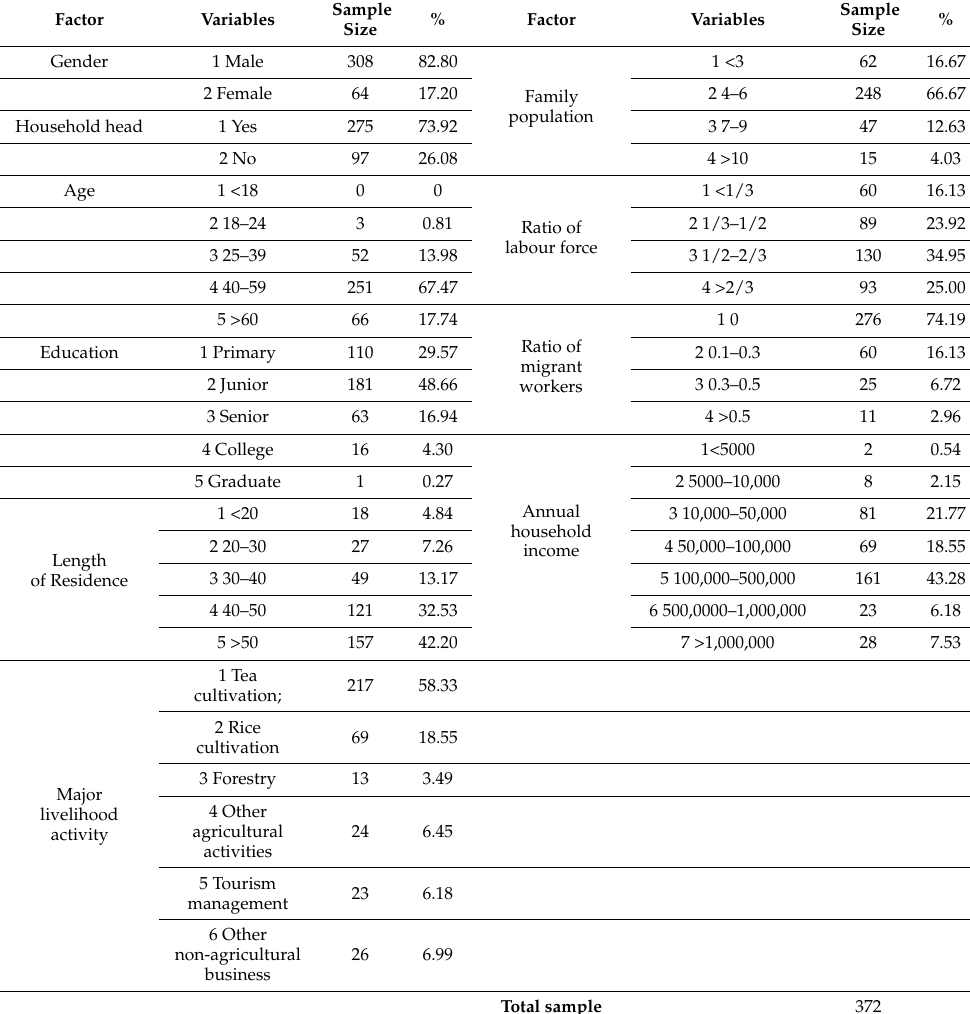
Table 2. Demographic characteristics of respondents and their